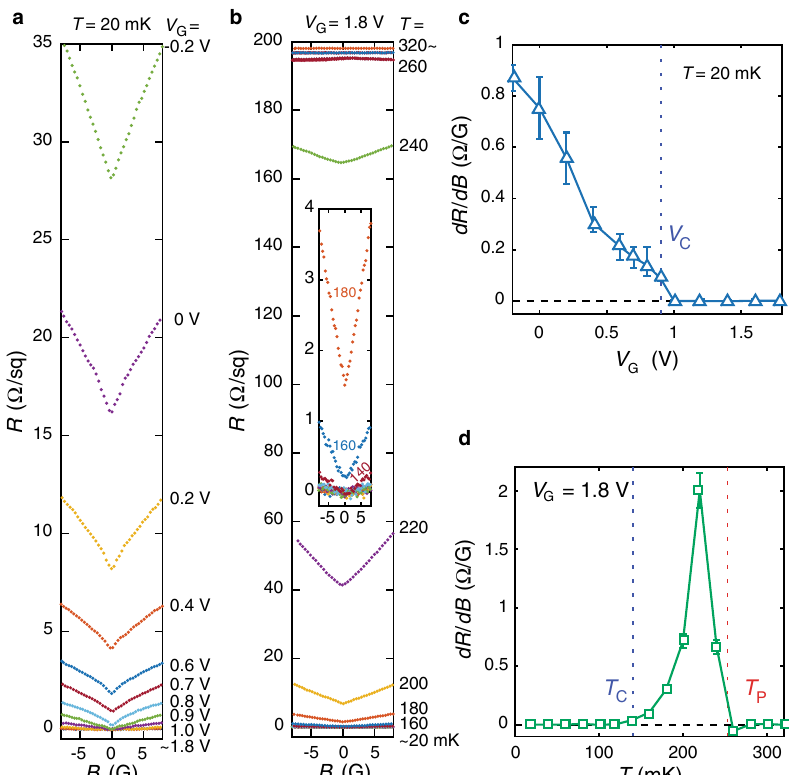
Fig. 2 Magnetoresistance as a probe of quantum and thermal phase transitions. a , b Magnetoresistance in the vicinity of zero magnetic fi eld, with varying gate voltage and fi xed T = 20 mK and varying temperature and fi xed V temperature below 200 mK. c , d dR / dB near B = 0 as a function of V G and T , calculated from a , b , respectively. Horizontal dashed lines show zero. Vertical dotted lines correspond to V C , T C , and T P , determined from Fig. 1. Error bars represent con fi dence intervals of fi tted slopes. All data in this fi gure are from Sample